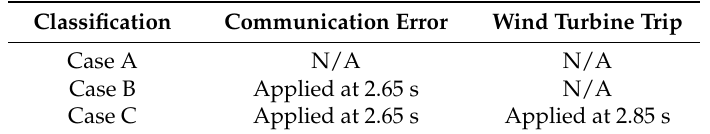
Table 3. Designed situations for analysis.